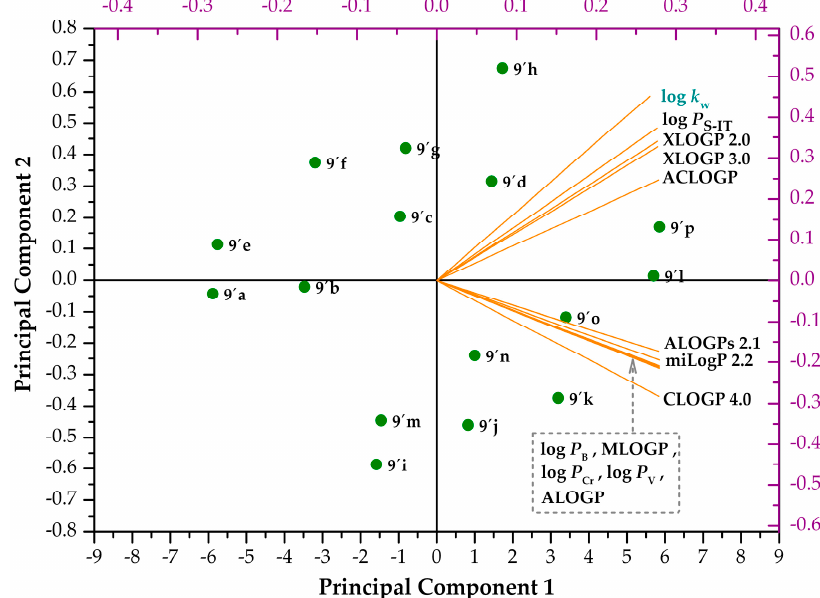
Figure 4. Two-dimensional biplot (mapping) showing both Principal Component 1 and 2 scores of the compounds 9 ′ a – p and loadings of extrapolated chromatographic (log k w ; 1a – p ) and in silico lipophilicity variables, i.e., log P S-IT , XLOGP 2.0, XLOGP 3.0, ACLOGP, ALOGPs 2.1, miLogP 2.2,